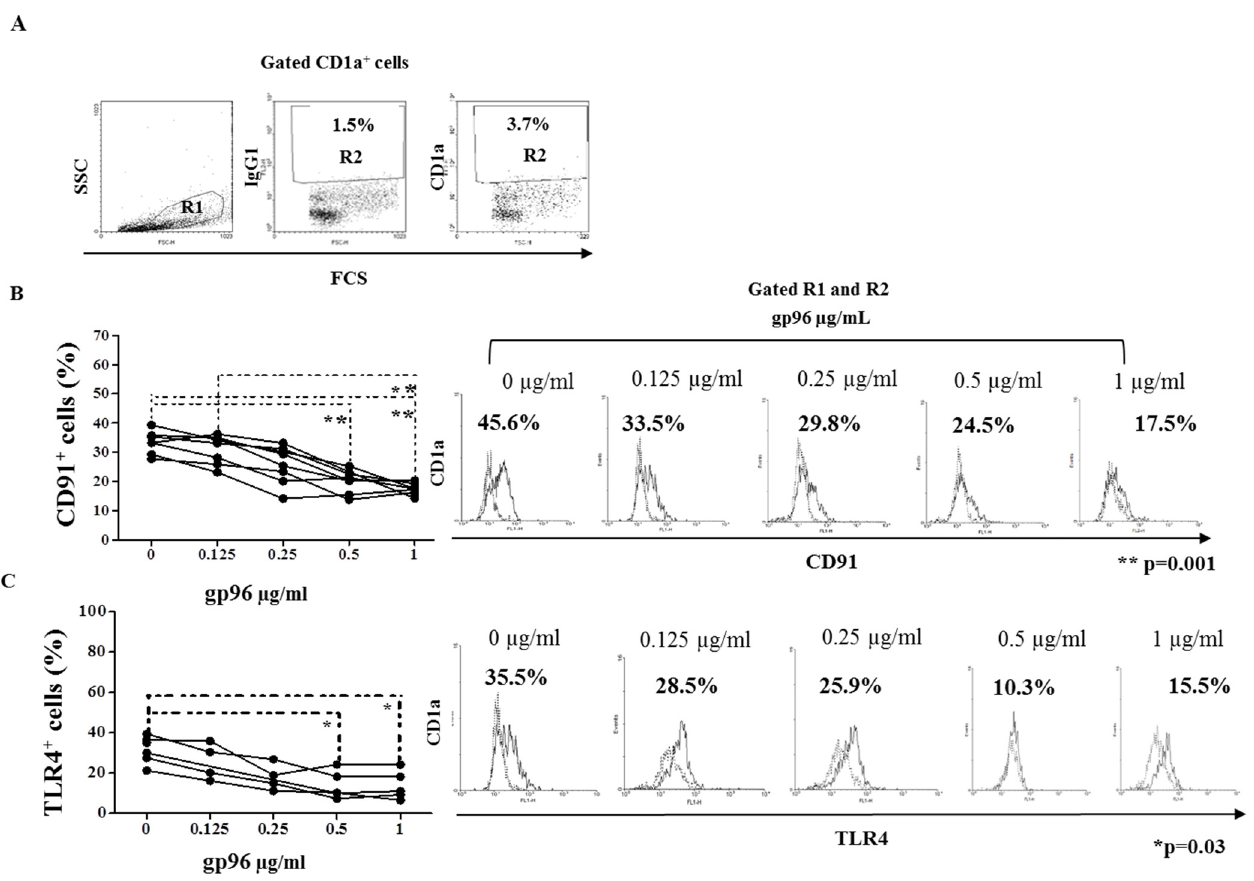
Figure 3. Specific binding of gp96 for CD91 and TLR4 on CD1a + dendritic cells from the suspension of early pregnancy decidual mononuclear cells. Dot plots show the gating of decidual CD1a + cells within the region (R) 1 (back gating for CD1a + events) and R2 gate (CD1a + events) with respect to isotype mouse IgG1 ( A ). The results of binding assays are shown as the percentages of CD91 ( B ) or TLR4 ( C ) expressing CD1a + cells calculated as the difference compared to isotype-matched controls after the treatment with gp96 at the indicated concentrations. Histograms illustrate the labeling of CD1a + cells with antibodies of interest (solid histogram curves) in relation to isotype-matched control (dashed histogram curves). Levels of statistical significance: ** p = 0.001 and * p = 0.03.